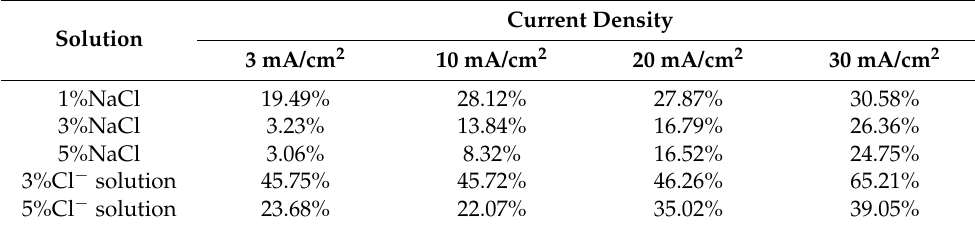
Table 4. Decrease of corrosion efficiency in NaCl solution and concrete simulated pore